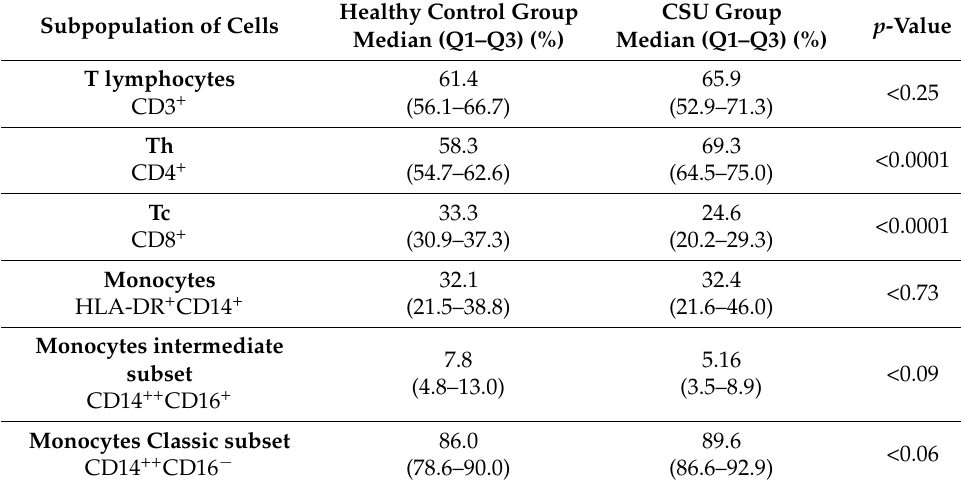
Table 2. Cells characteristics in the two tested cohorts. Data are presented as median and lower and upper quartiles (Q1; Q3). Statistical significance of the results was analyzed with a Mann–Whitney test. Healthy Control Subpopulation of Cells